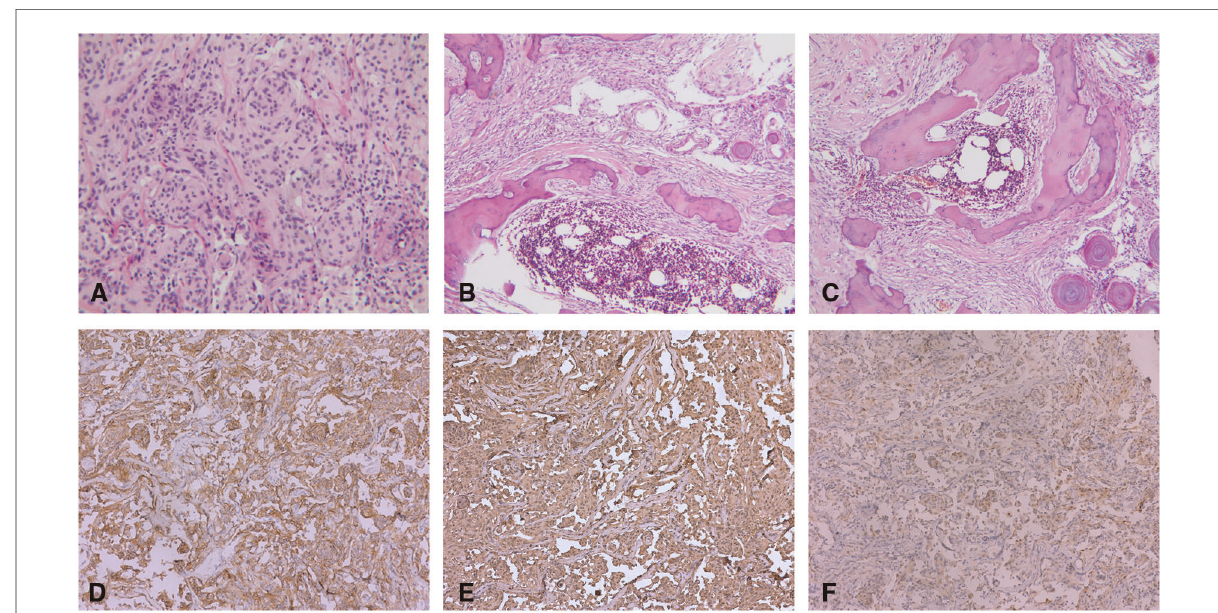
FIGURE 2 ( A ) Tumors are demonstrated to be a spinal meningioma on histology (H&E stain, original magni fi cation ×100). ( B,C ) Psammoma bodies around the tumor cells. Mature bone tissues around the tumor cells, including trabecular bone, as well as bone marrow with hematopoiesis (H&E stain, original magni fi cation ×40). Immunohistochemically, the neoplastic meningothelial cells are immunoreactive for ( D ) epithelial membrane antigen (EMA) (×10), ( E ) vimentin (×10), and ( F ) soluble protein-100 (S-100)